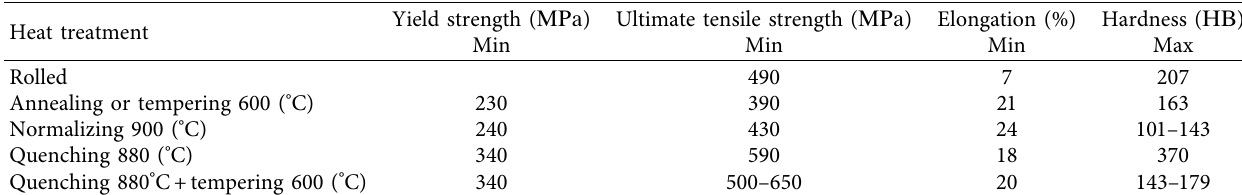
Table 2: Mechanical properties of steel C22 F (1.1151) according to standard EN 10083-2:2006 [23].